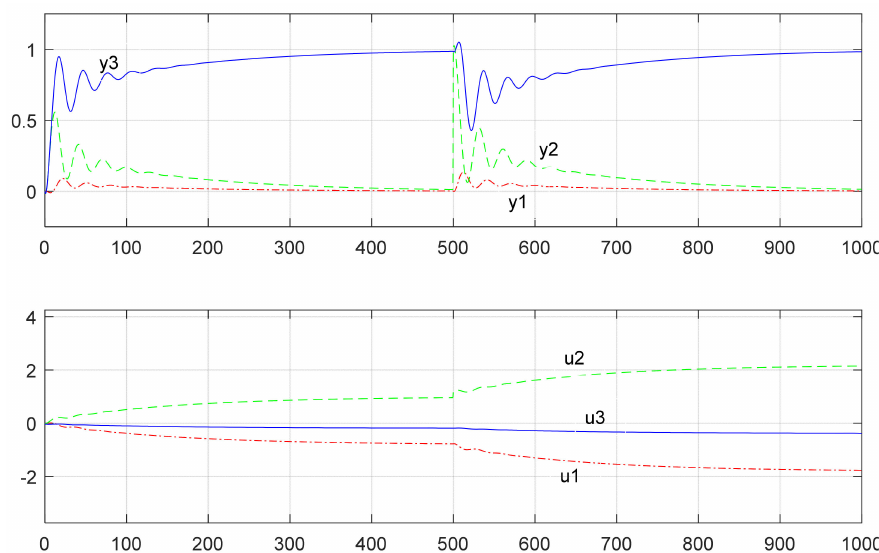
Figure 3. Inconsiderate reference tracking and disturbance regulation. Upper plot shows the system outputs y 1 , y 2 , and y 3 , as functions of time. Lower plot shows the system inputs u 1 , u 2 , and u 3 , as functions of time. All references and output disturbances in Figure 1 are zero, except r 3 = σ ( t ) and